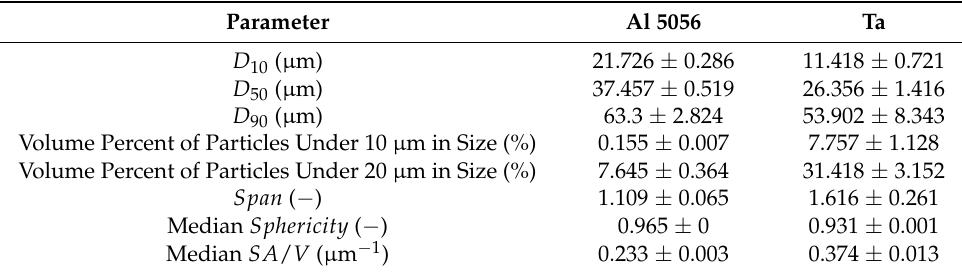
Table 2. Average and standard deviation values of several measured and calculated particle size and morphology parameters of all the Al 5056 and Ta powder samples in Lots #0 through